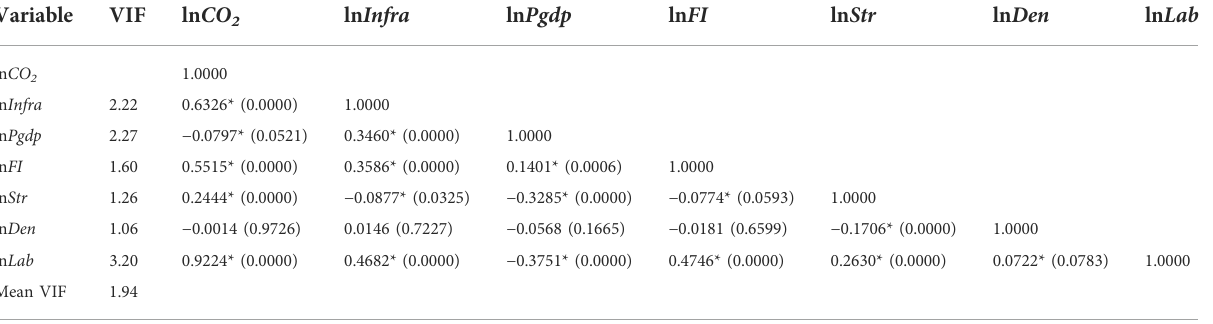
TABLE 2 Multicollinearity test and matrix of the correlations between all variables.